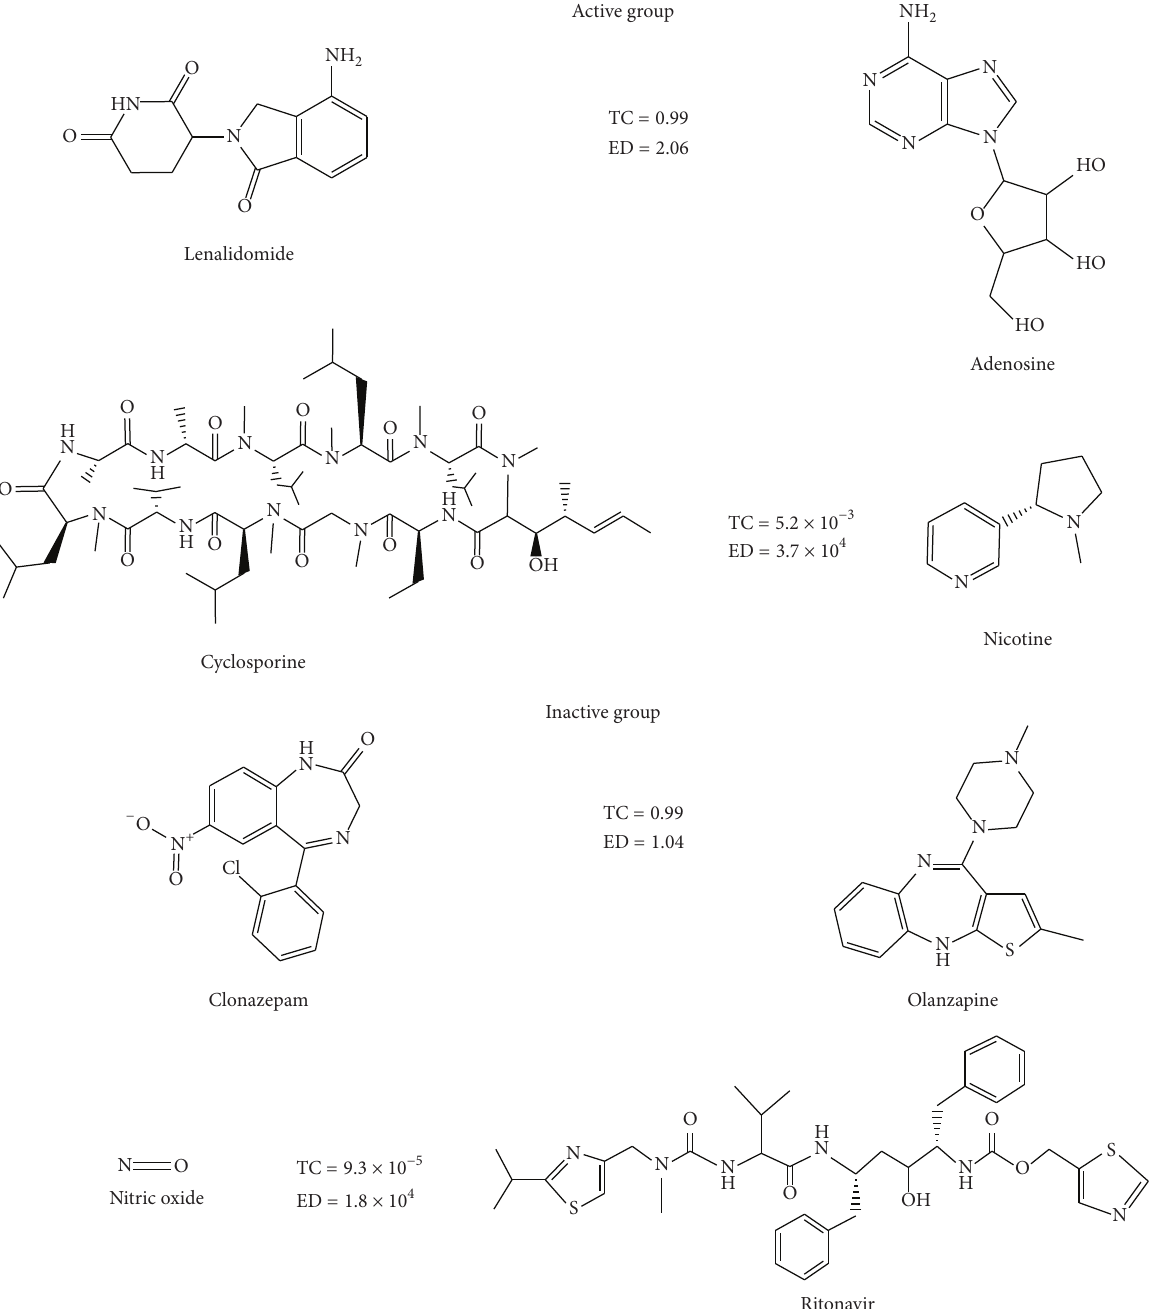
[39, 40]. An AUC value represents a perfect test, whereas AUC of 0.5 represents a worthless = 1